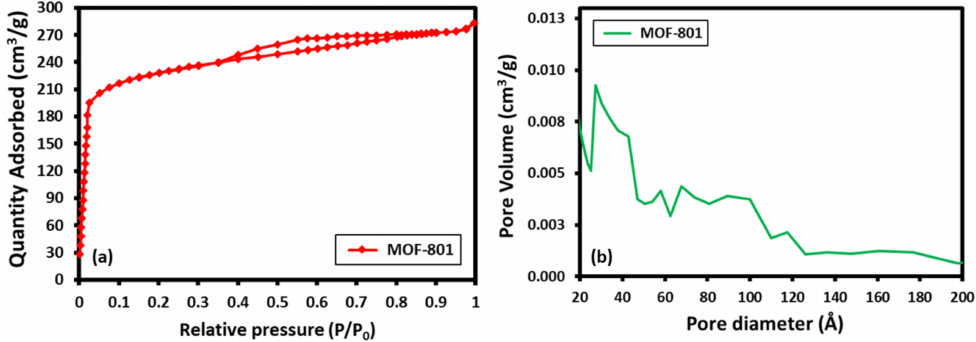
Figure 5. ( a ) N 2 adsorption–desorption isotherm and ( b ) pore size distribution of